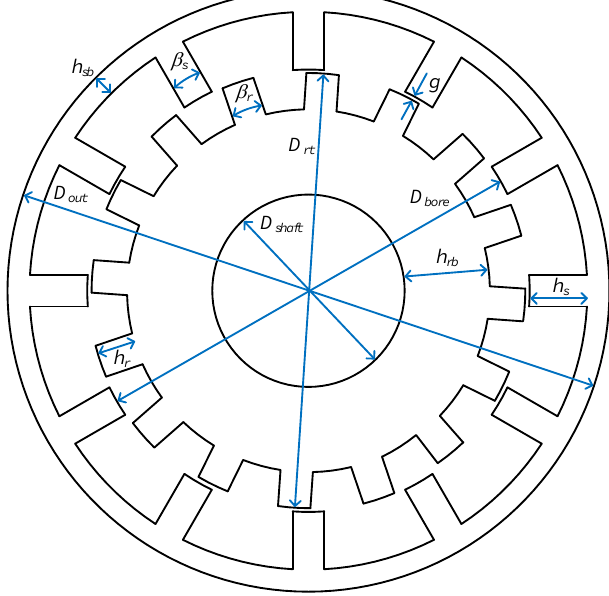
Figure 7. Main geometry parameters of the 12/16 SRM.